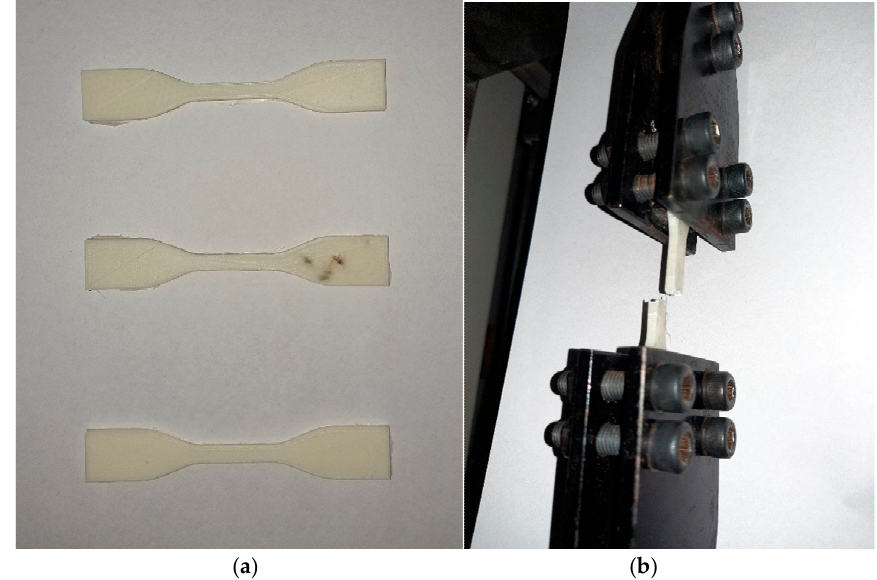
Figure 3. ( a ) Tensile testing of finished samples ( b ) Sample prepared through FDM process .